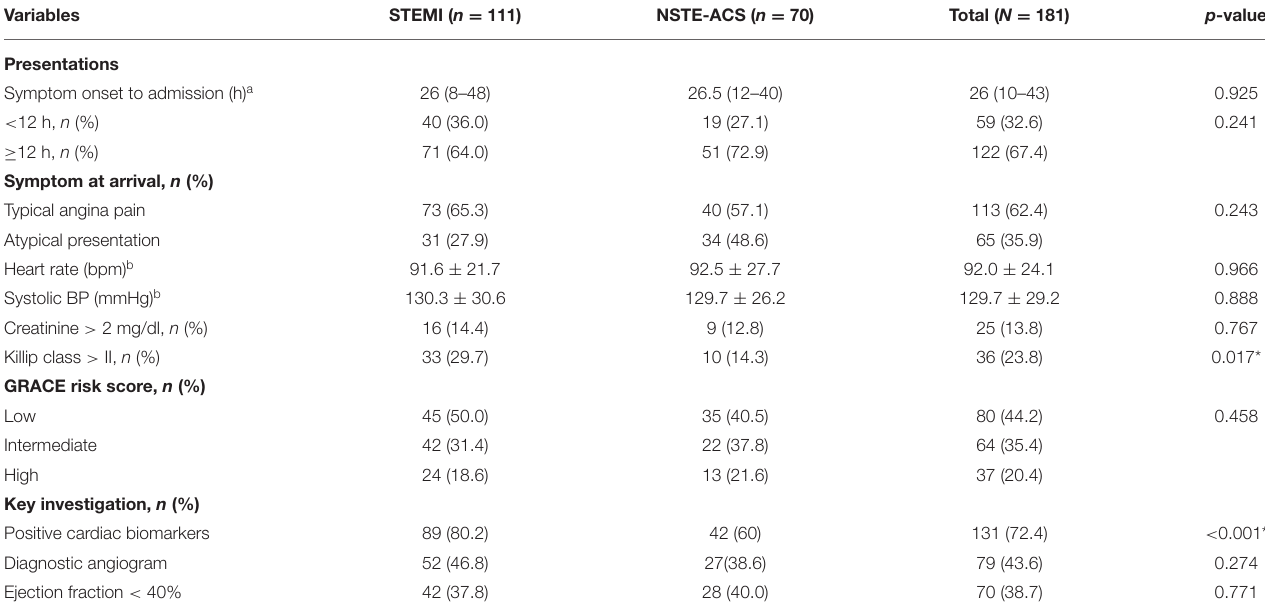
TABLE 2 | Clinical presentations and diagnostic evaluations by ACS subtype.